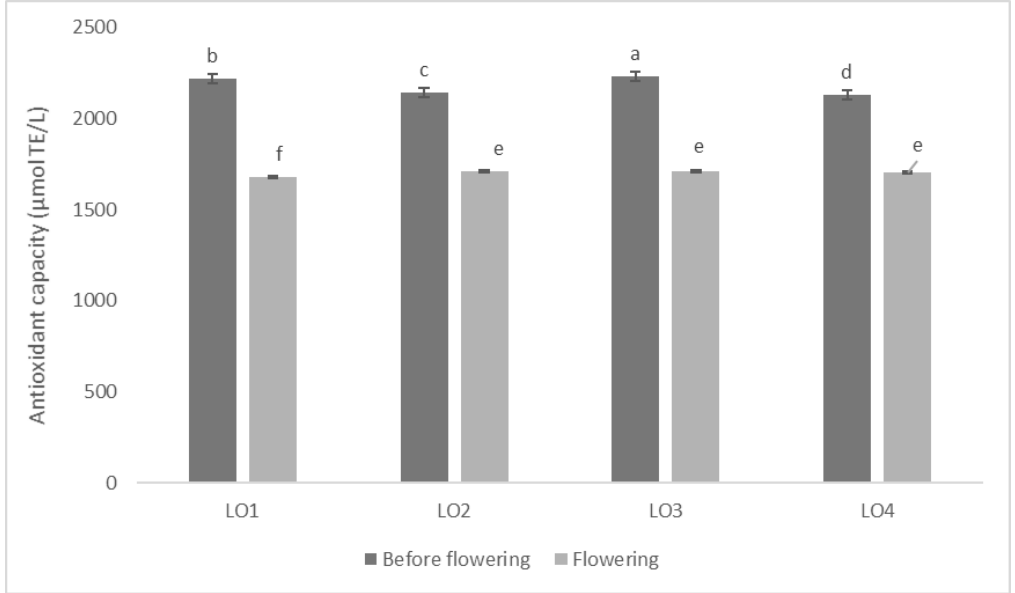
Figure 5. Antioxidant capacity ( µ mol TE/L) of wild garlic leaves from four different locations (LO1–4) before and in flowering stage. Different letters indicate significant differences between mean values at p ≤ 0.0001. Significance of interaction: L—location p ≤ 0.0001; P—phenophase p ≤ 0.0001; L × P—location and phenophase p ≤ 0.0001.